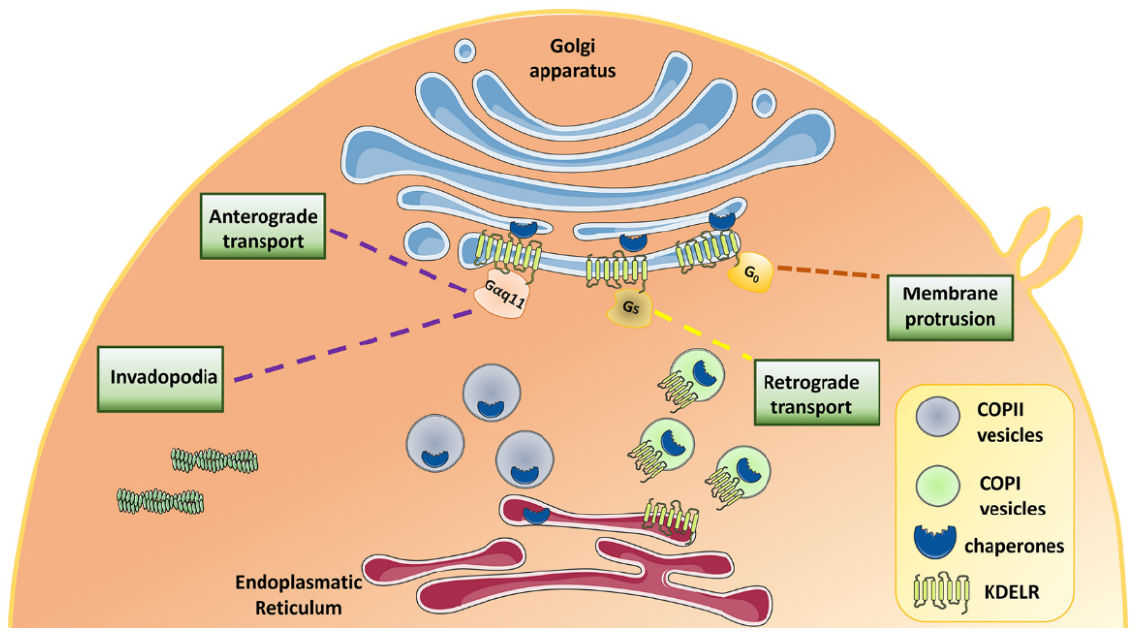
Figure 2. Schematic illustration of the role of KDELRs in the control of multiple cellular func- tions. KDELRs regulate the homeostasis of membrane transport between ER, Golgi, and plasma membrane via the Gq and Gs signaling pathways. KDELRs stimulate invadopodia formation via activation of Gq